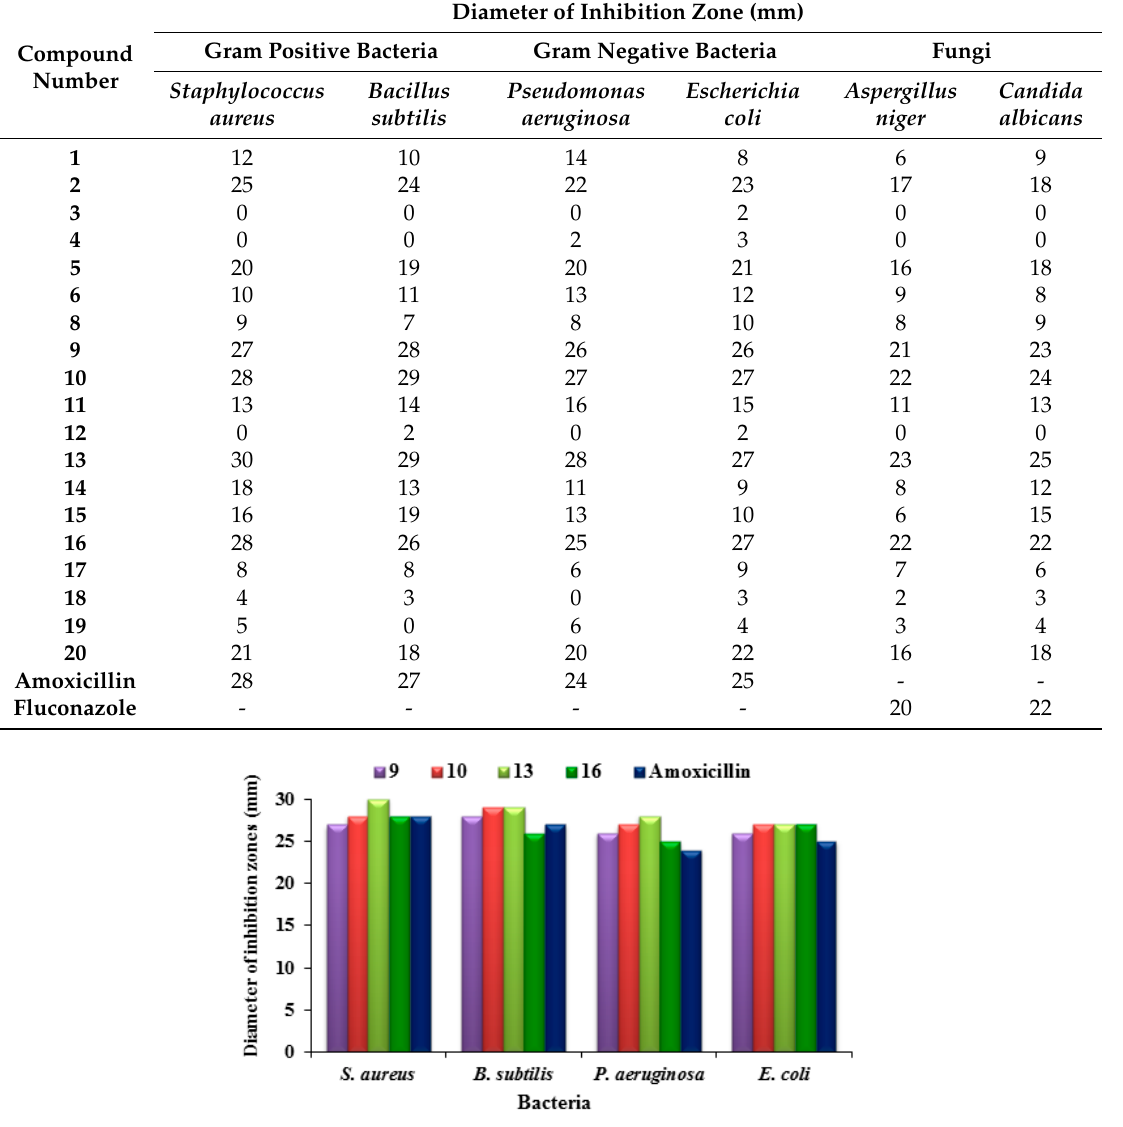
Figure 3. Antimicrobial activity of the most potent compounds against different bacterial